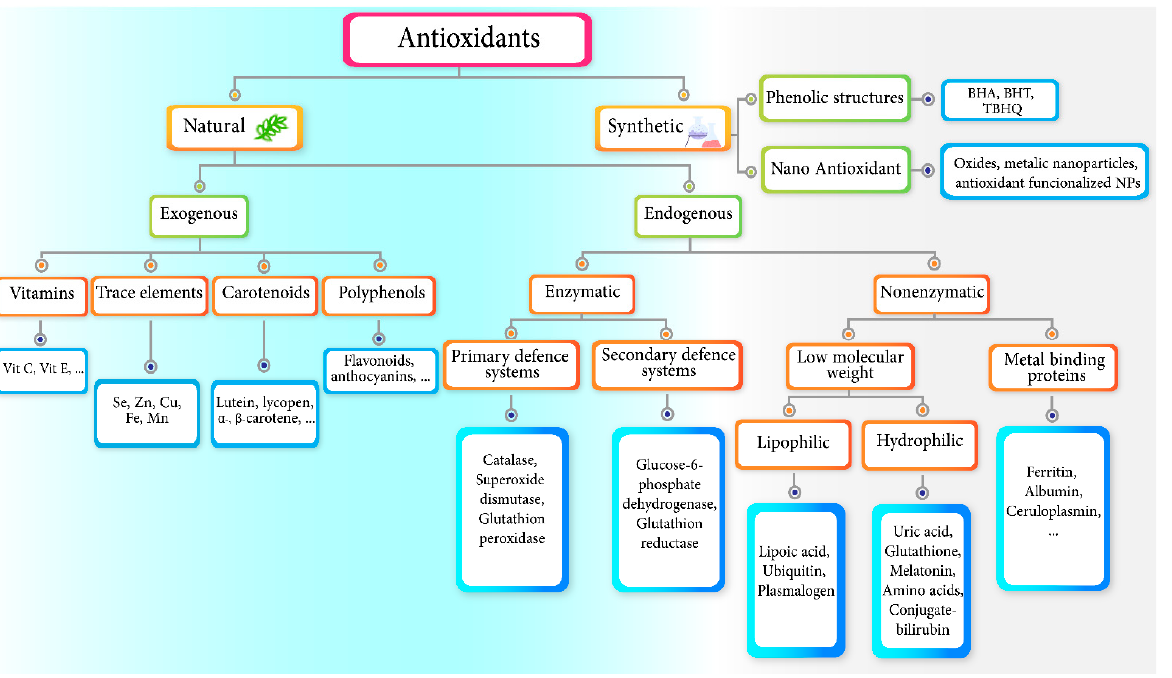
Figure 1. Summary of antioxidant classification